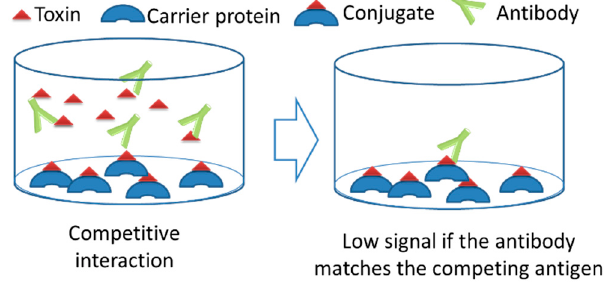
Figure 3. Schematic representation of competitive interaction.